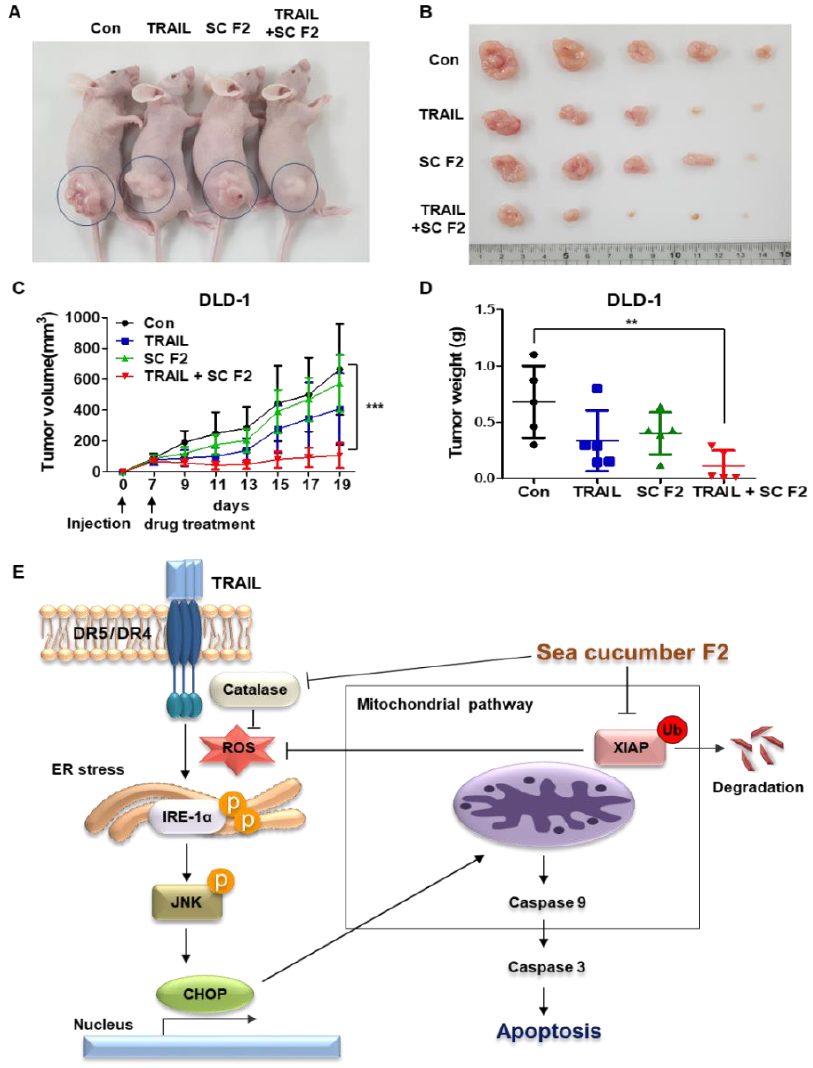
Figure 6. SC F2 enhanced TRAIL-induced apoptosis in vivo. ( A–C ) DLD-1 cells were inoculated into nude mice (n = 5 per group) at 5 × 10 6 per mouse subcutaneously. Mice received 4 ng / kg TRAIL and 50 mg / kg SC F2 either alone or in combination at day 19 after tumor implantation. Representative tumors of each group are shown. Tumor volume was calculated every 2 days for 19 days according to the following equation: tumor volume (mm 3 ) = π / 6 × length × (width) 2 . Maximum tumor area and its corresponding section were calculated using MetaMorph software (Molecular Devices). ( D ) The average tumor weight in nude mice after administration of TRAIL and SC F2 alone or in combination. ( E ) Schematic diagram for a working model of SC F2 sensitizing TRAIL-induced apoptosis. *** p <